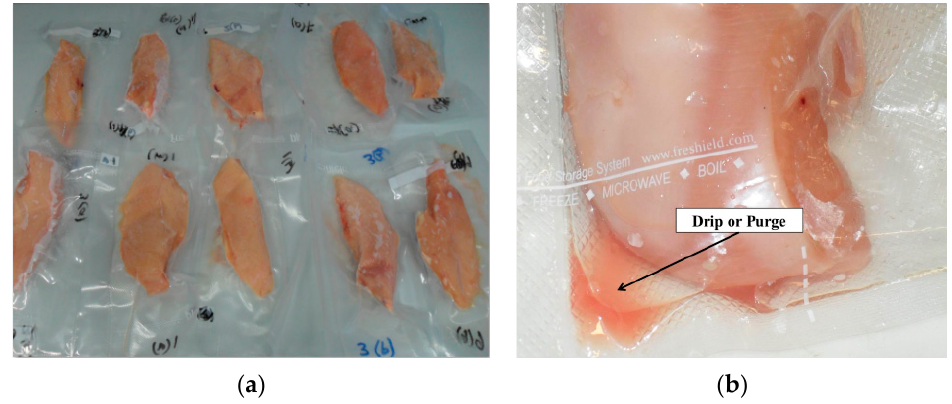
Figure 5. Studied broiler breast fillets. ( a ) Samples stored in freezer; ( b ) Equilibrated sample with collected drip.